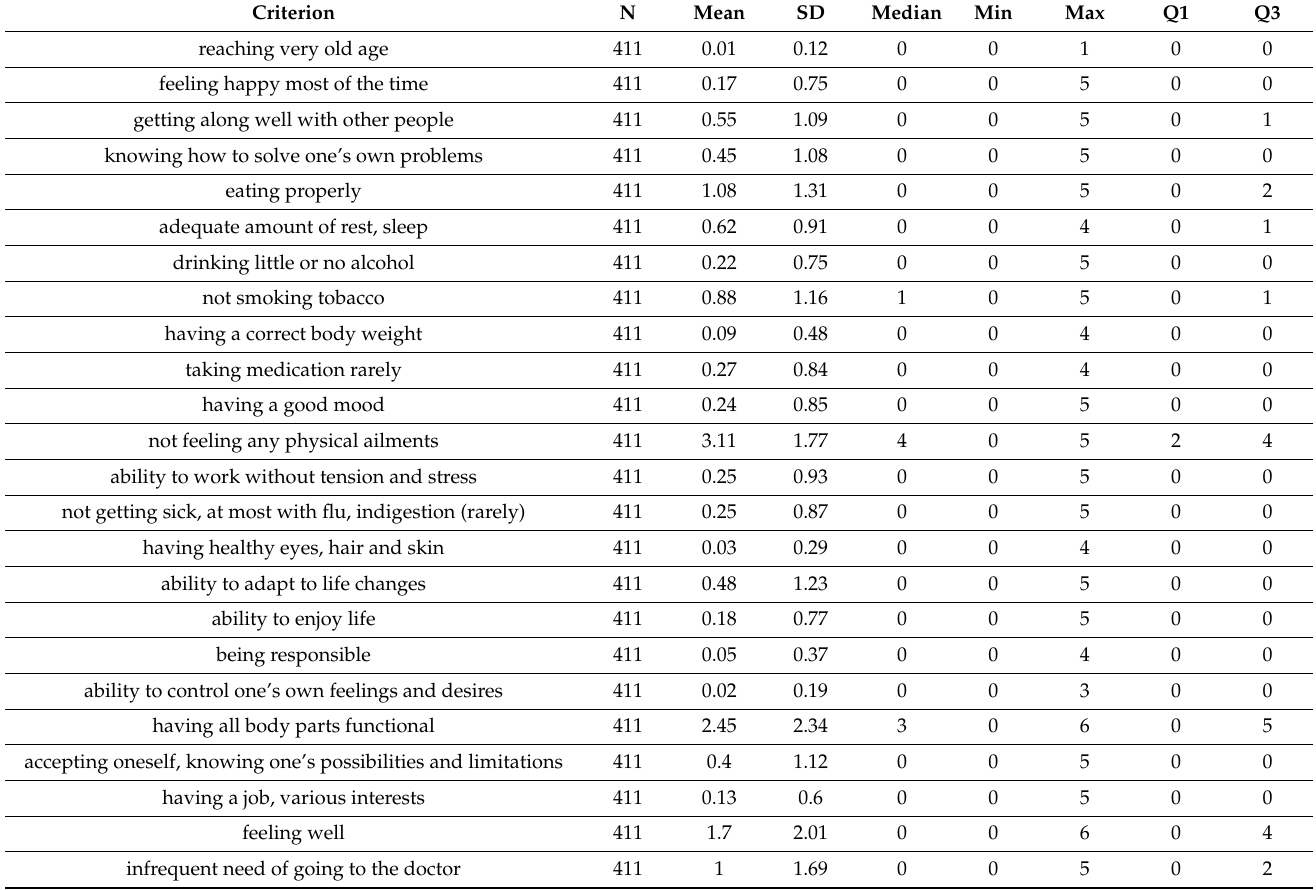
Table 2. List of Health Criteria of the studied